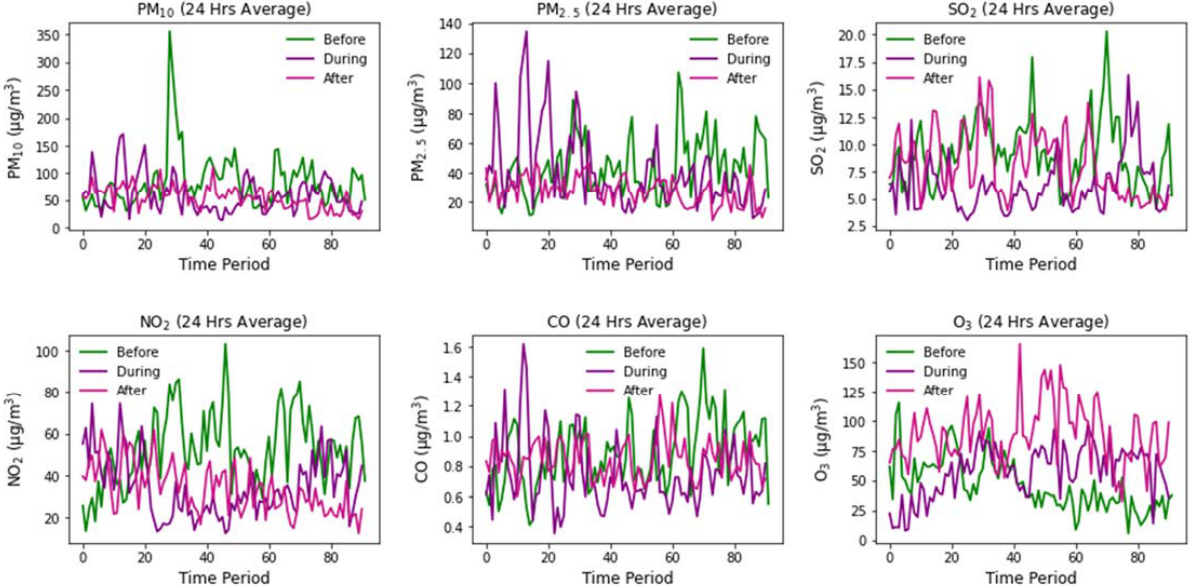
Figure 2. Temporal evolution of 24 h average concentrations of PM 10 , PM 2.5 , SO 2 , NO 2 , CO, and O 3 before, during and after the lockdown periods.